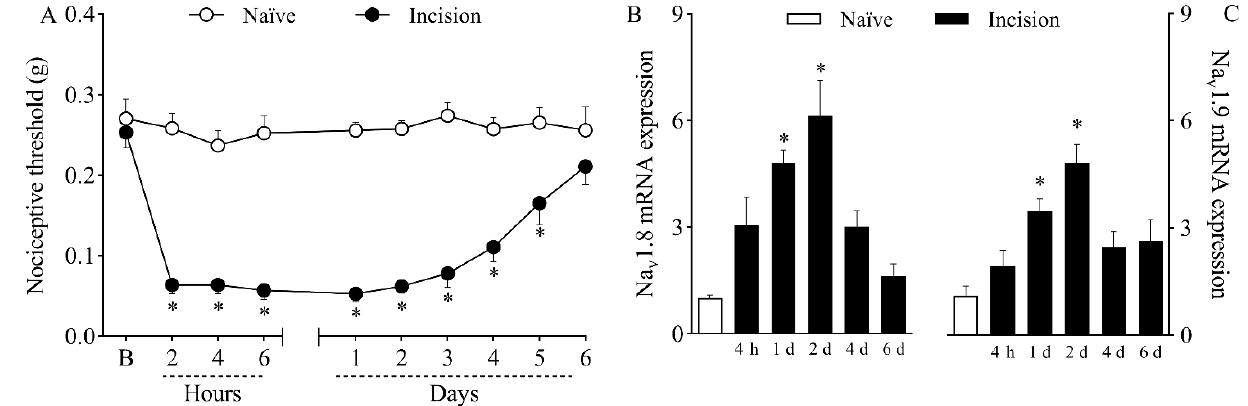
Figure 1. Mechanical hypernociception and increased expression of Na v 1.8 and Na v 1.9 in the dorsal root ganglia (DRG) caused by plantar incision. Mice were induced to the plantar incision model of postoperative pain. No surgical procedures were performed on naïve mice. ( A ) The mechanical nociceptive threshold (axis of ordinates) was evaluated at baseline ( B ) and at different times in hours and days after plantar incision (axis of abscissas). Values represent the filament weight (g) to which mice respond in 50% of presentations. Data are expressed as means ± SD ( n = 6). * p < 0.05 compared with naïve group. Two-way ANOVA followed by Bonferroni’s test. ( B , C ) The levels of Na v 1.8 ( B ) and Na v 1.9 ( C ) mRNA in the DRG (axis of ordinates) were determined by Real-Time PCR at different times in hours (h) and days (d) after plantar incision (axis of abscissas). Target gene expression (2 − ∆∆ Ct ) was determined using Gapdh as housekeeping gene. Data are expressed as means ± SD ( n = 6). * p < 0.05 compared with naïve group. One-way ANOVA followed by Tukey’s test.